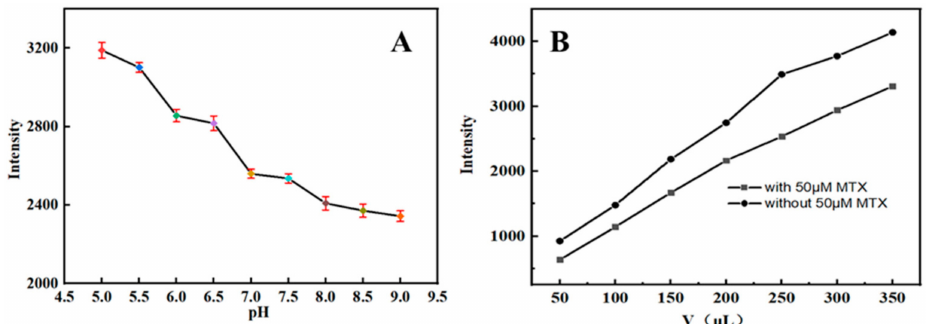
Figure 5. Effect of pH ( A ) and volume ( B ) of PEI-CQDs on the fluorescence intensity of the detec- tion system.